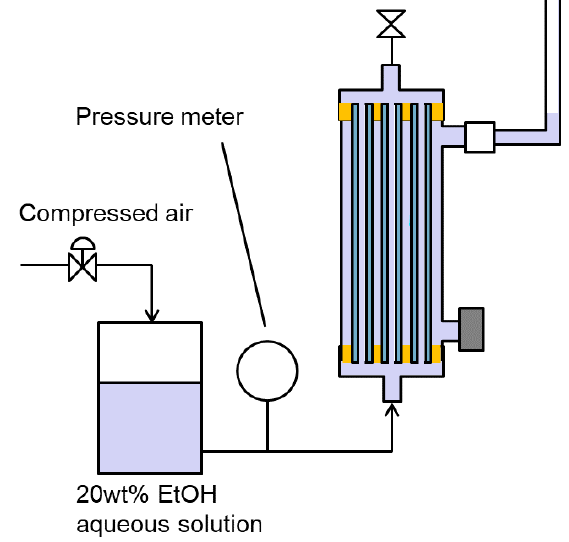
Figure 4. How to measure LEP of membrane.